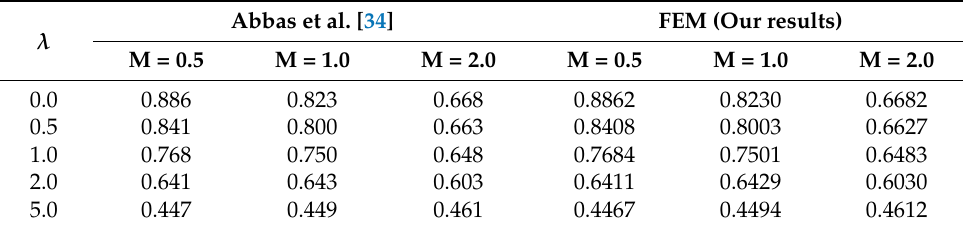
Table 3. Comparison of Nusselt number − θ (cid:48) ( 0 ) for λ and M at ξ = 1, Pr = 2.0 when other parameters are